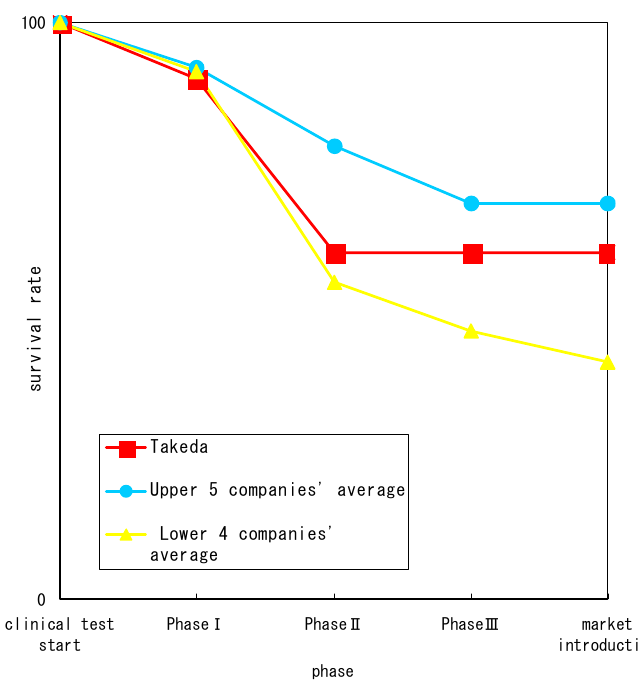
Figure 1. Survival Distribution